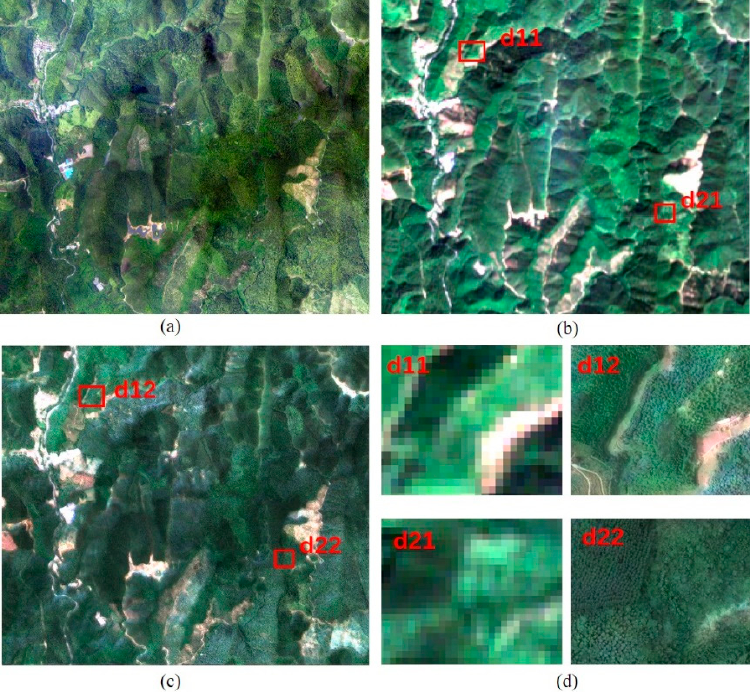
Figure 9. The relative image of fusion. ( a ) Aerial image. ( b ) Sentinel-2 image. ( c ) The results of Sentinel-2 image fused with aerial image. ( d ) The details of fusion results. The left part is the Sentinel-2 image; the right part shows the image after fusion.